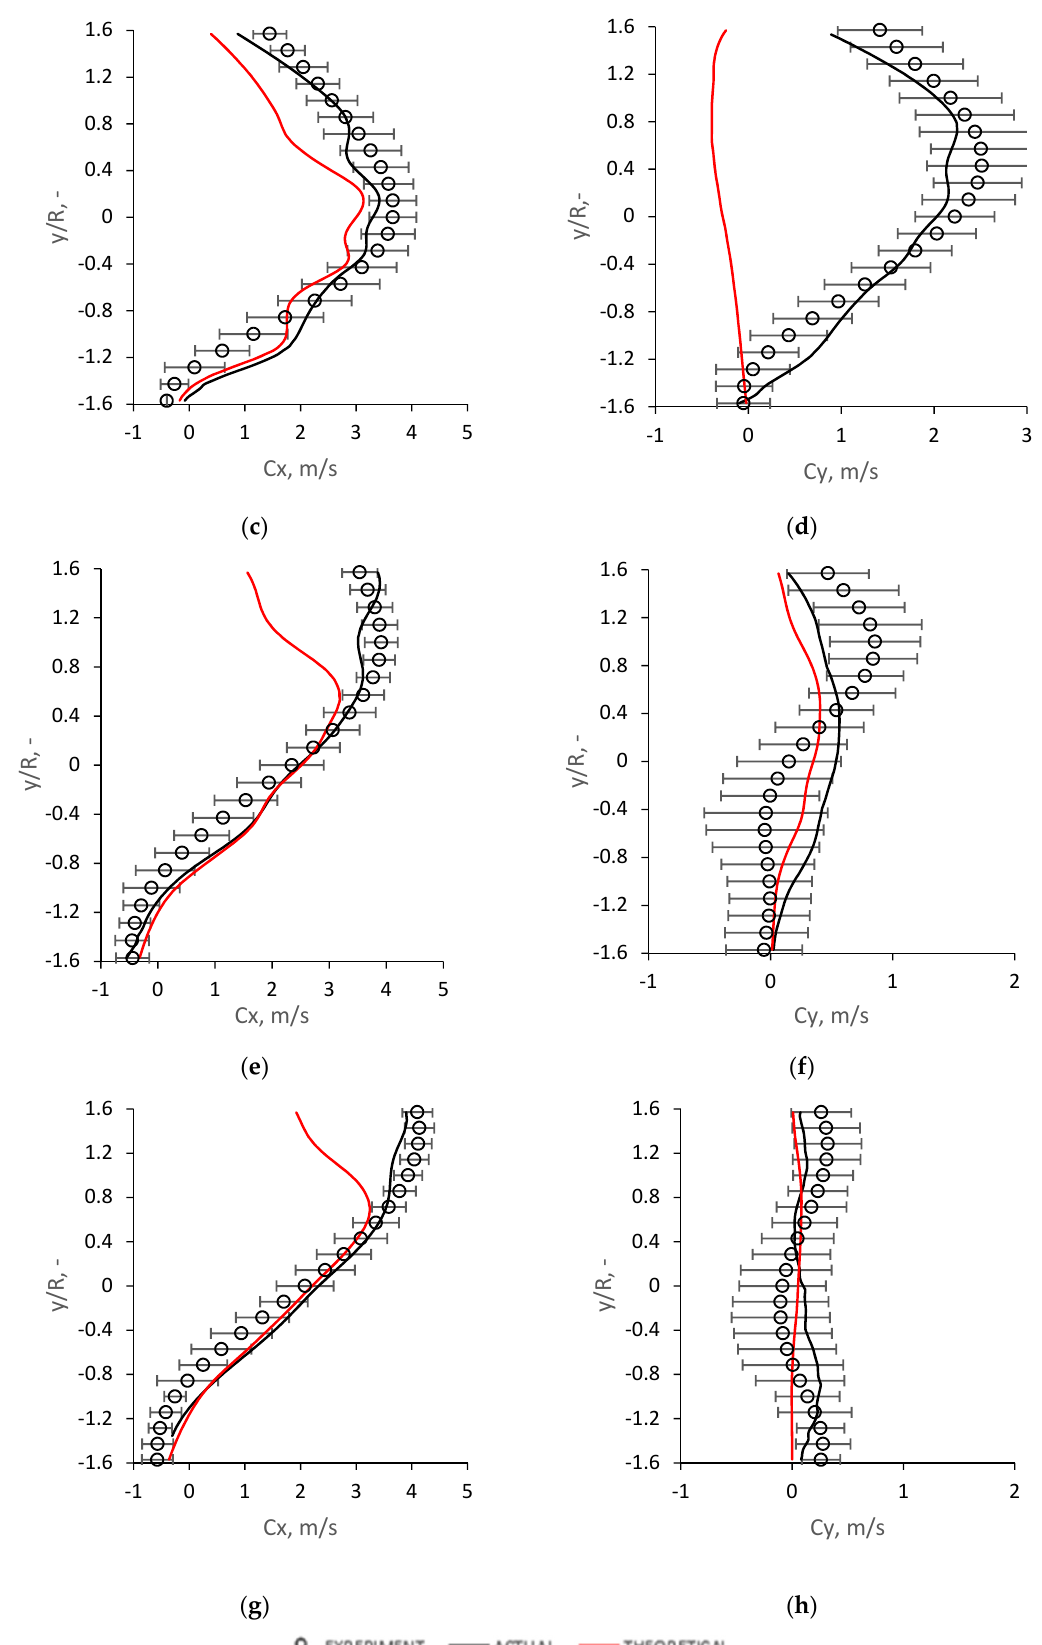
Figure 15. Comparison of the C x and C y velocity profiles on different planes for the theoretical